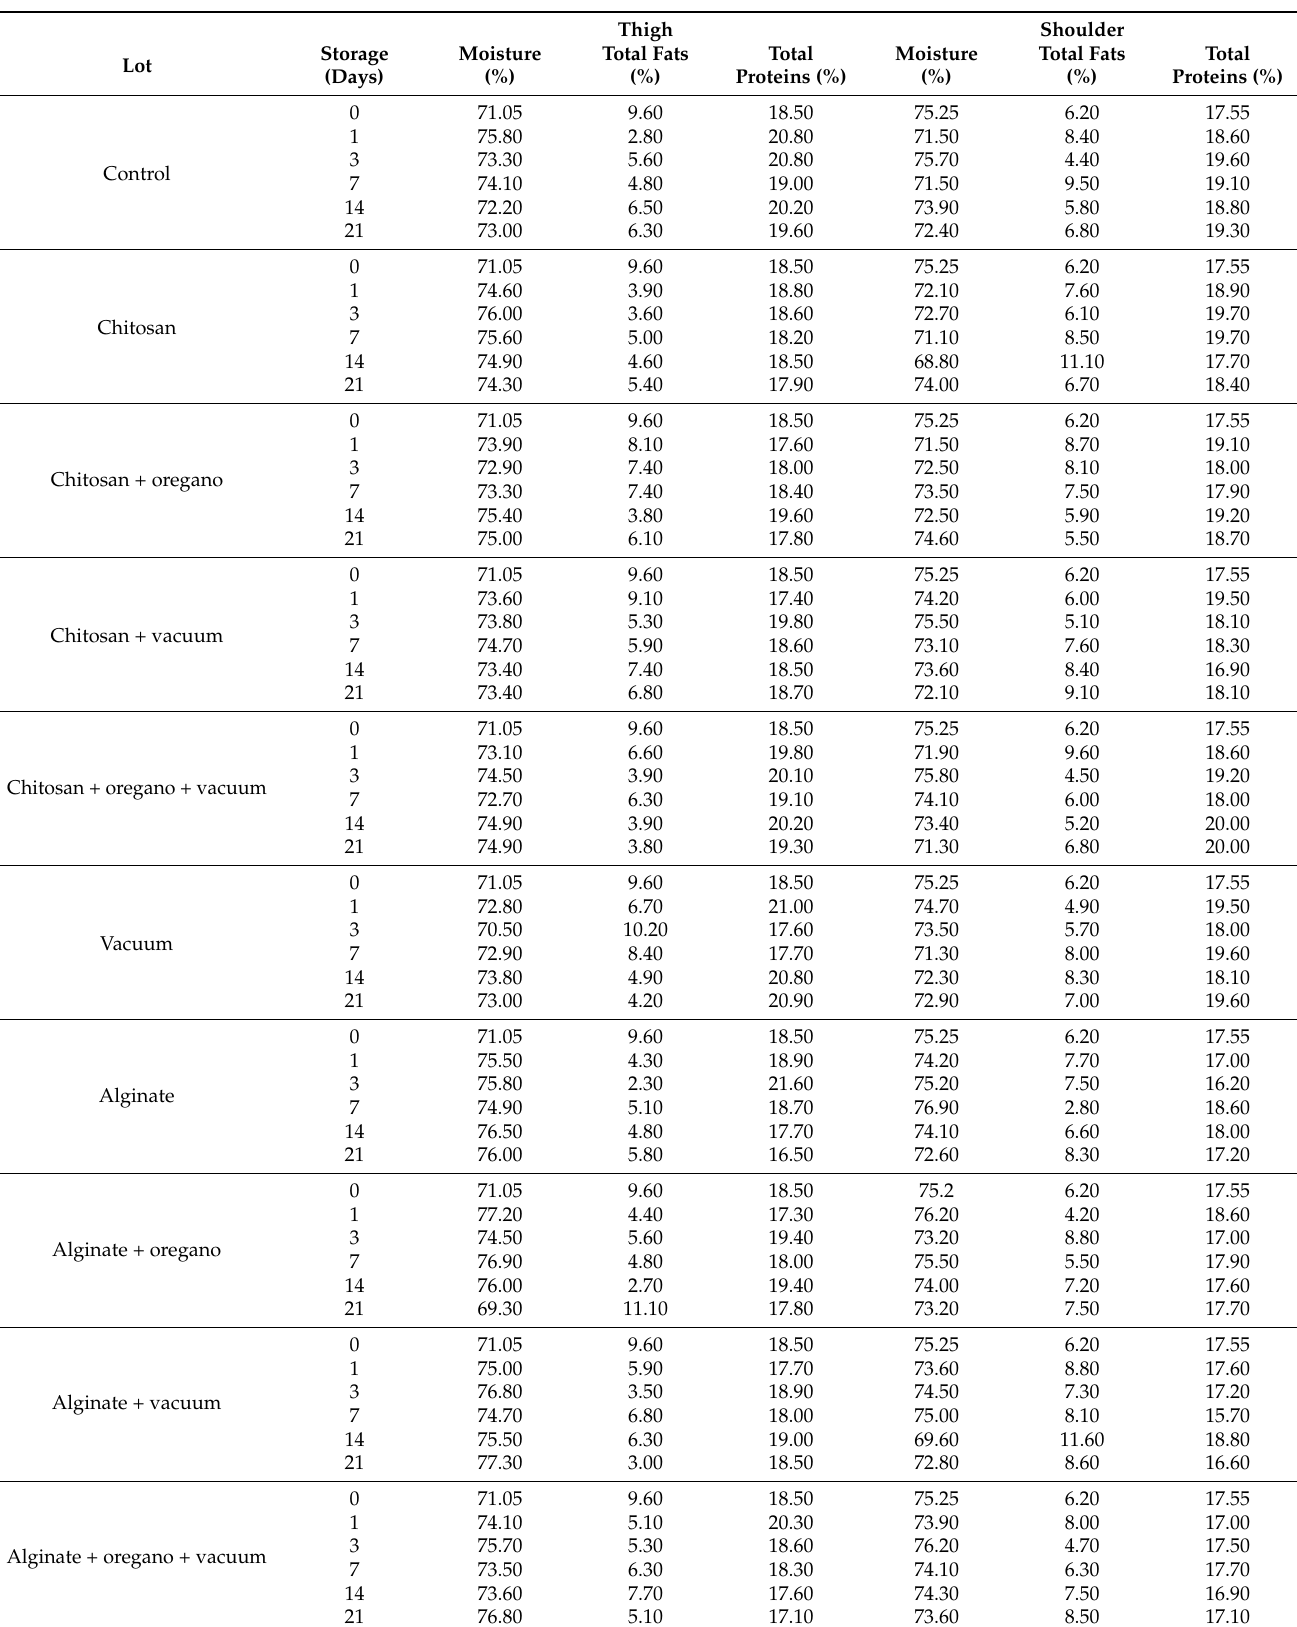
Table 1. Chemical composition of mutton